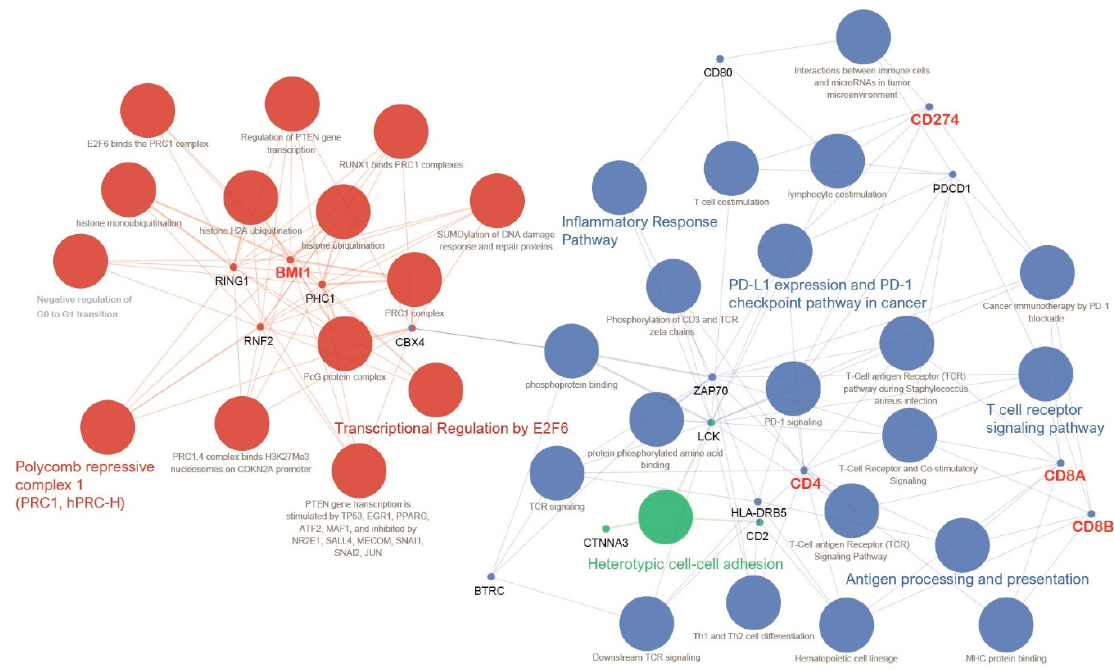
Figure 4. Grouping of networks based on functionally enriched Gene Ontology (GO) terms and pathways related to BMI1. The functionally grouped networks are linked to their biological functions, where only the most significantly enriched terms in the group are labeled: polycomb repressive complex 1 (PRC1, hPRC-H), transcriptional regulation by E2F6, inflammatory response pathway, PD-L1 expression and PD-1 checkpoint pathway in cancer, antigen processing and presentation, T cell receptor signaling pathway, and heterotypic cell-cell adhesion.